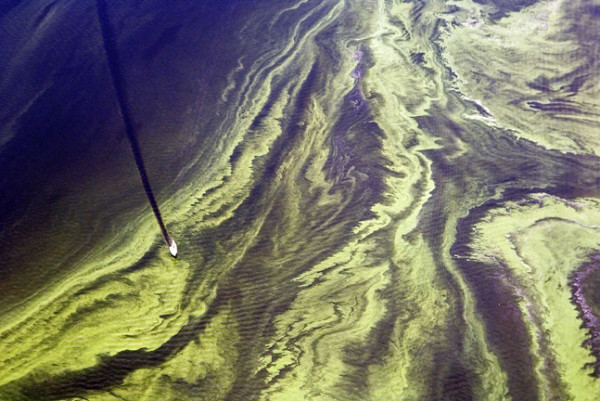
Aerial image showing a yacht traversing a Microcystis bloom, St Johns River, Florida, August 2005. Image copyright Bill Yates / CYPIX 2005.